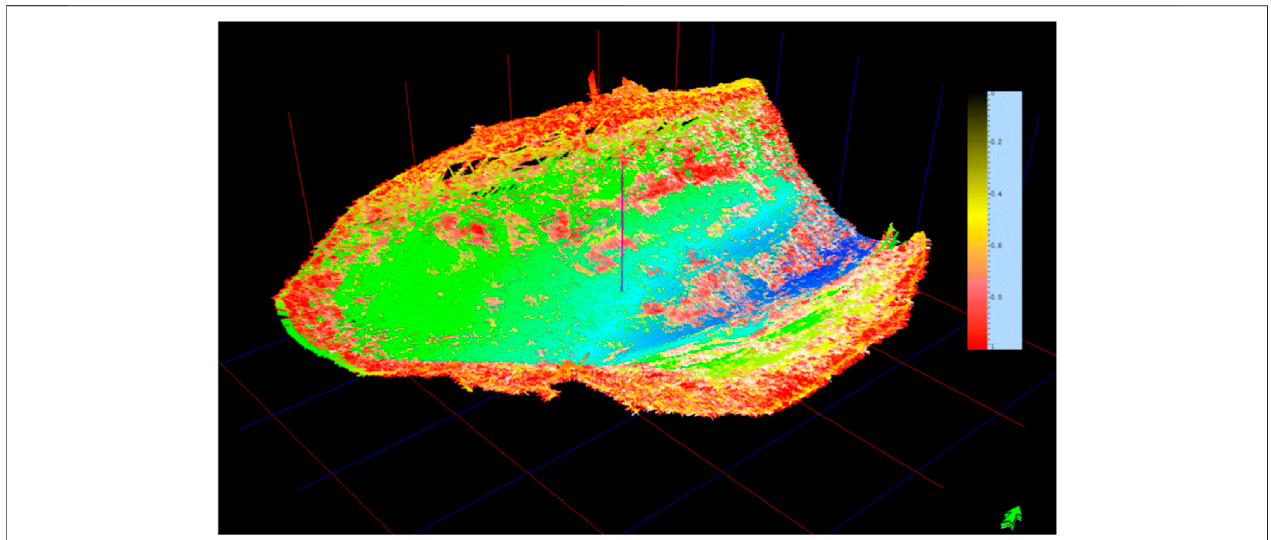
FIGURE 8 | Predicted fractures at the bottom of Wufeng-Longmaxi Formation in well Anye A.